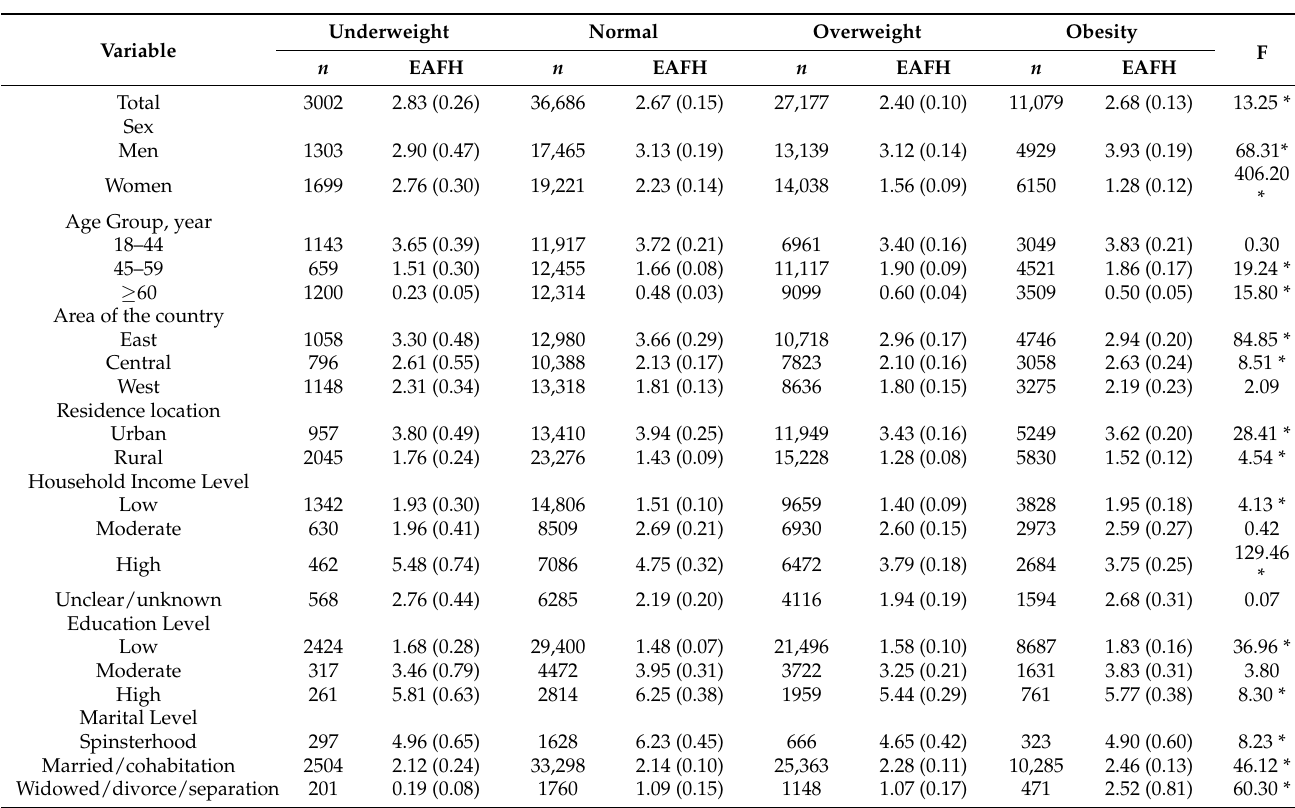
Table A1. Frequencies of EAFH of different BMI